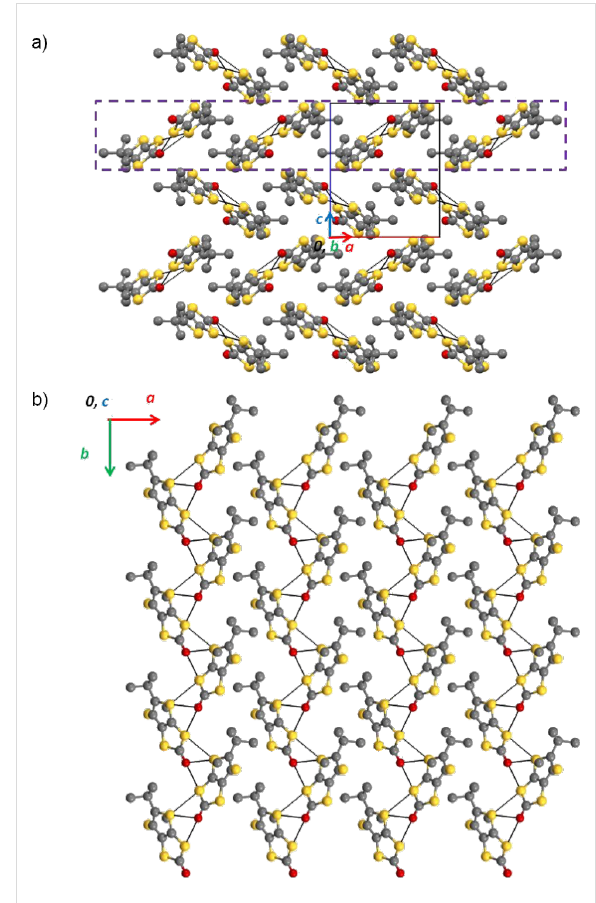
Figure 4: Crystal structure of I a) view along the b axis , b) Partial view of one layer of bi-chains in the a,b plane corresponding to the dashed line in